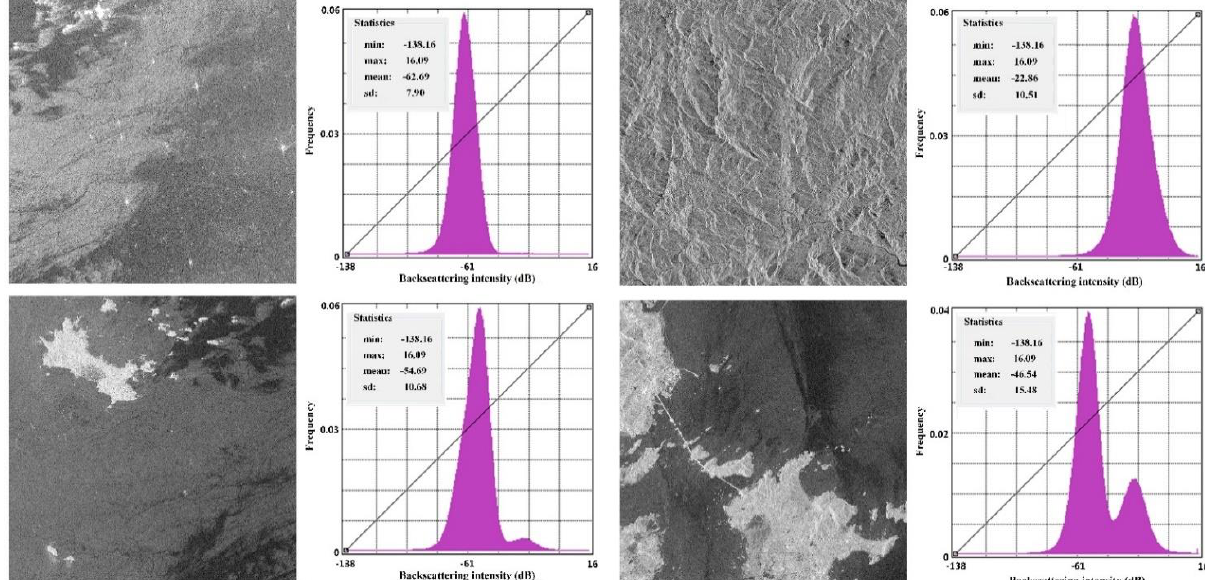
Fig. 2 Backscattering intensity value comparisons for land and sea areas.